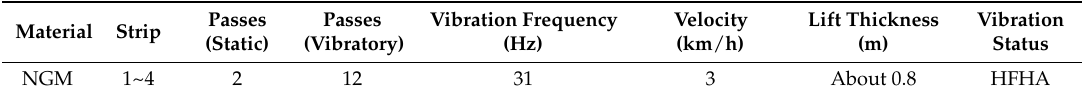
Figure 12. Photos of field rolling test in the rockfill zone. Table 2. Test scheme for field rolling experiment.